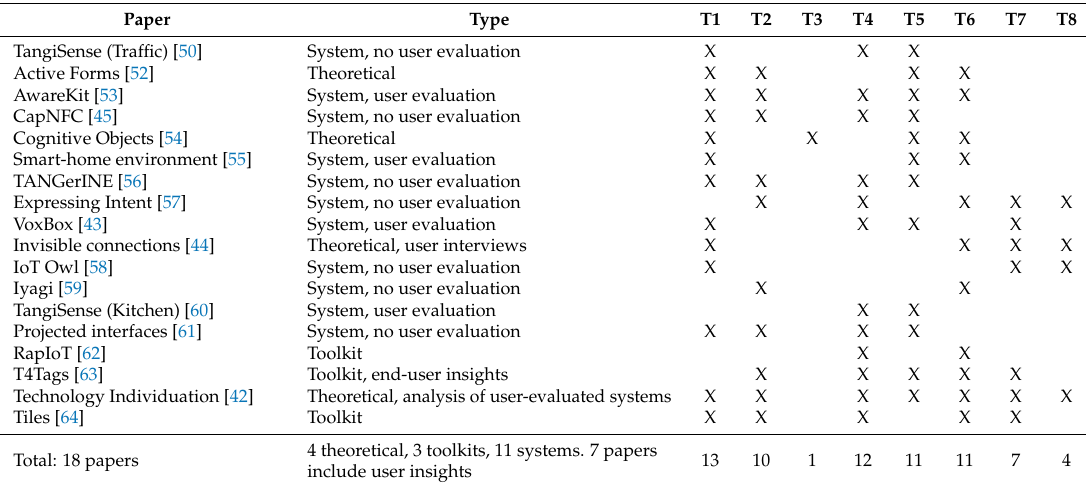
Table 1 resumes the results of the meta-analysis for the 18 selected papers. Table 1. Results of the